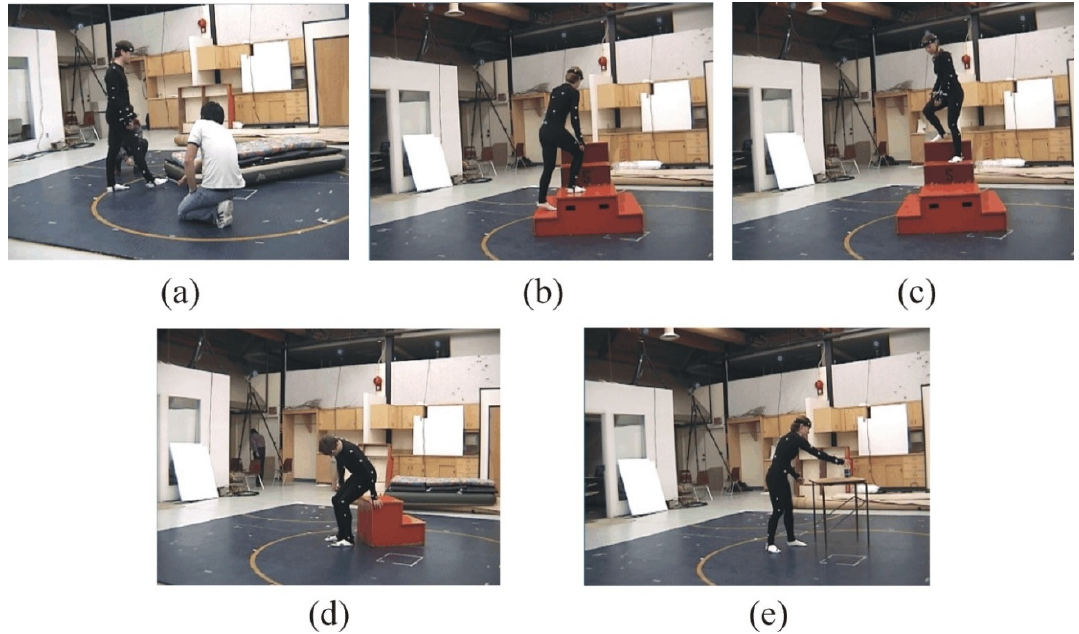
Figure 3. Motion analysis/quantification of the common daily activities among seniors: ( a ) a walk with eyes-closed (followed by a trip); ( b ) going upstairs; ( c ) walking downstairs; ( d ) sitting down and standing up; ( e ) reaching for an object.